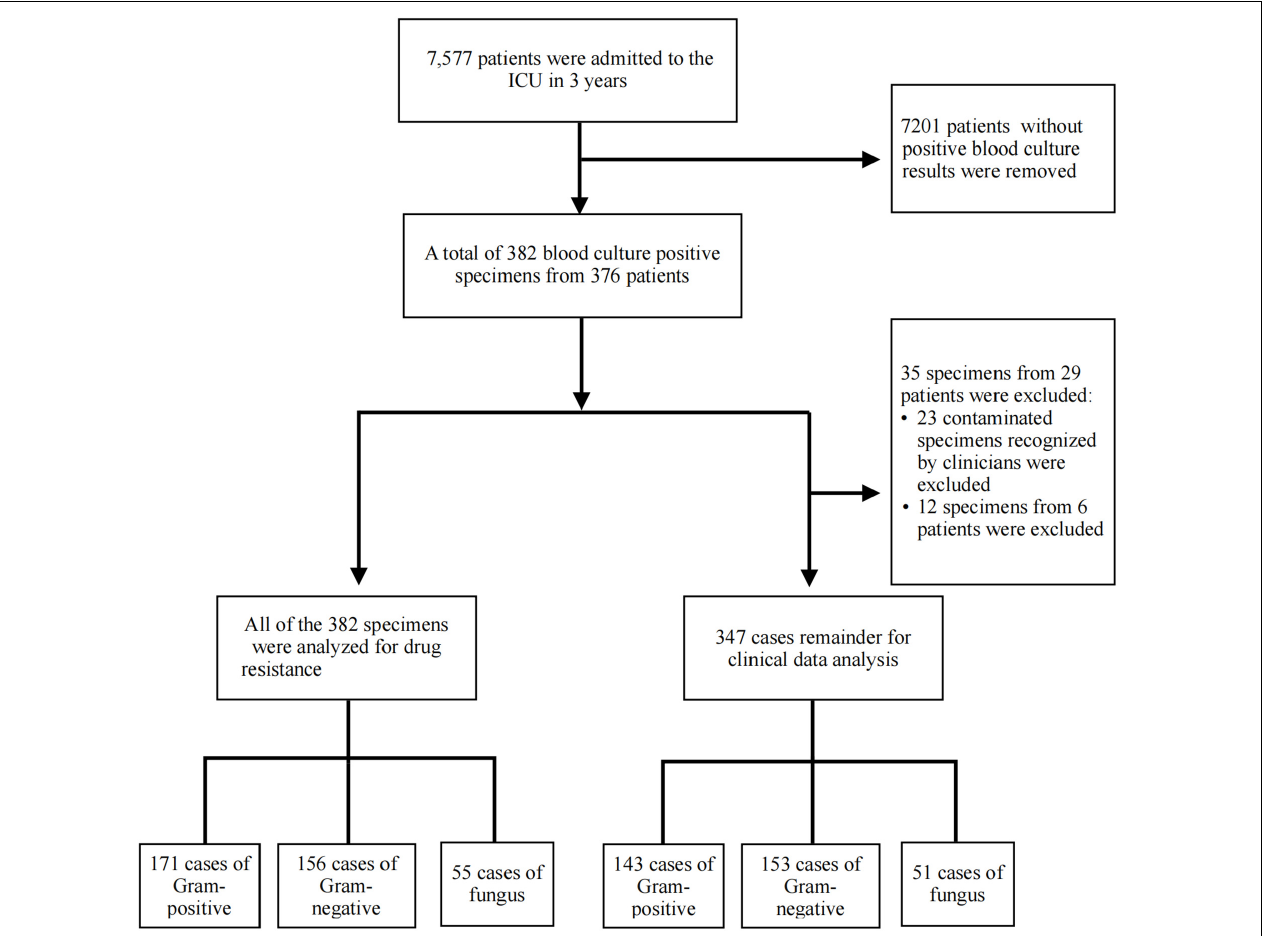
FIGURE 1 | Study flow diagram. A total of 382 blood culture positive specimens were analyzed for drug resistance, including 171 cases of Gram-positive bacteria, 156 cases of Gram-negative bacteria, and 55 cases of fungus. After excluding contaminated strains recognized by clinicians and one bottle with more than one organism, 347 cases of bloodstream infection (BSI) remainder were included in the clinical data analysis, including 143 cases of Gram-positive bacteria, 153 cases of Gram-negative bacteria, and 51 cases of fungus.